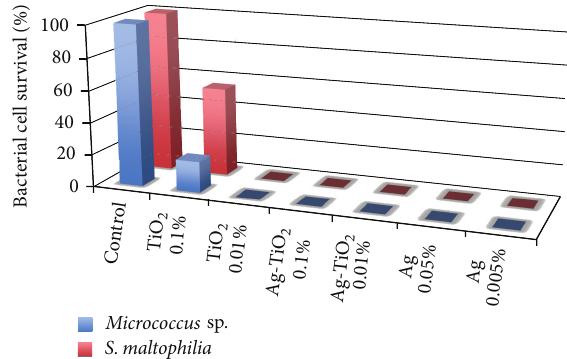
Figure 5: Histogram showing the percentage of survival cells in water of two bacterial strains tested against products under UV and solar lamp for 20h. Controls were carried out with only